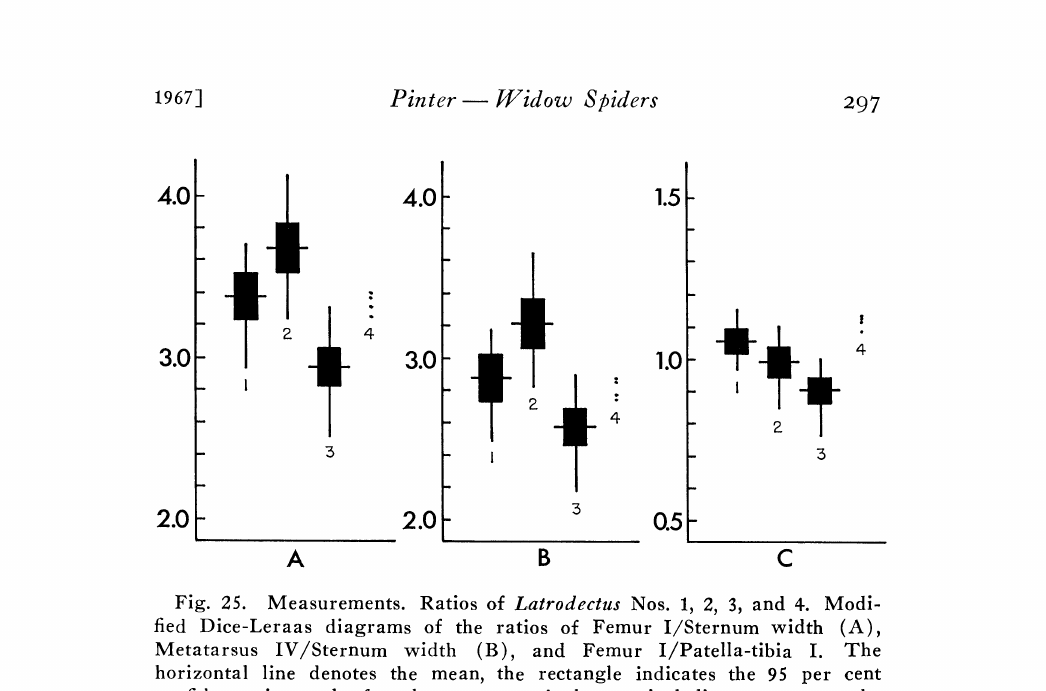
Fig. 25. Measurements. Ratios of L.atrodectus Nos. 1, 2, 3, and 4. Modi- fied Dice-Leraas diagrams of the ratios of Femur I/Sternum width (A), Metatarsus IV/Sternum width (B), and Femur I/Patella-tibia I. The horizontal line denotes the mean, the rectangle indicates the 95 per cent confidence intervals for the mean, and the vertical line represents the observed range. N equals 30 for Latrodectus Nos. 1, 2 and 3; N equals 4 for Latrodectus No.